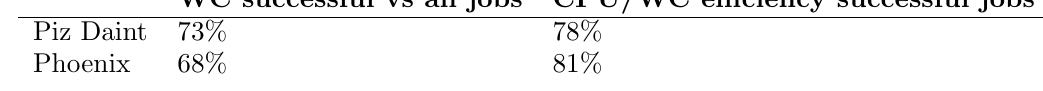
Table 1. Reliability and performance indicators for Piz Daint (8 months) and Phoenix (12 months)